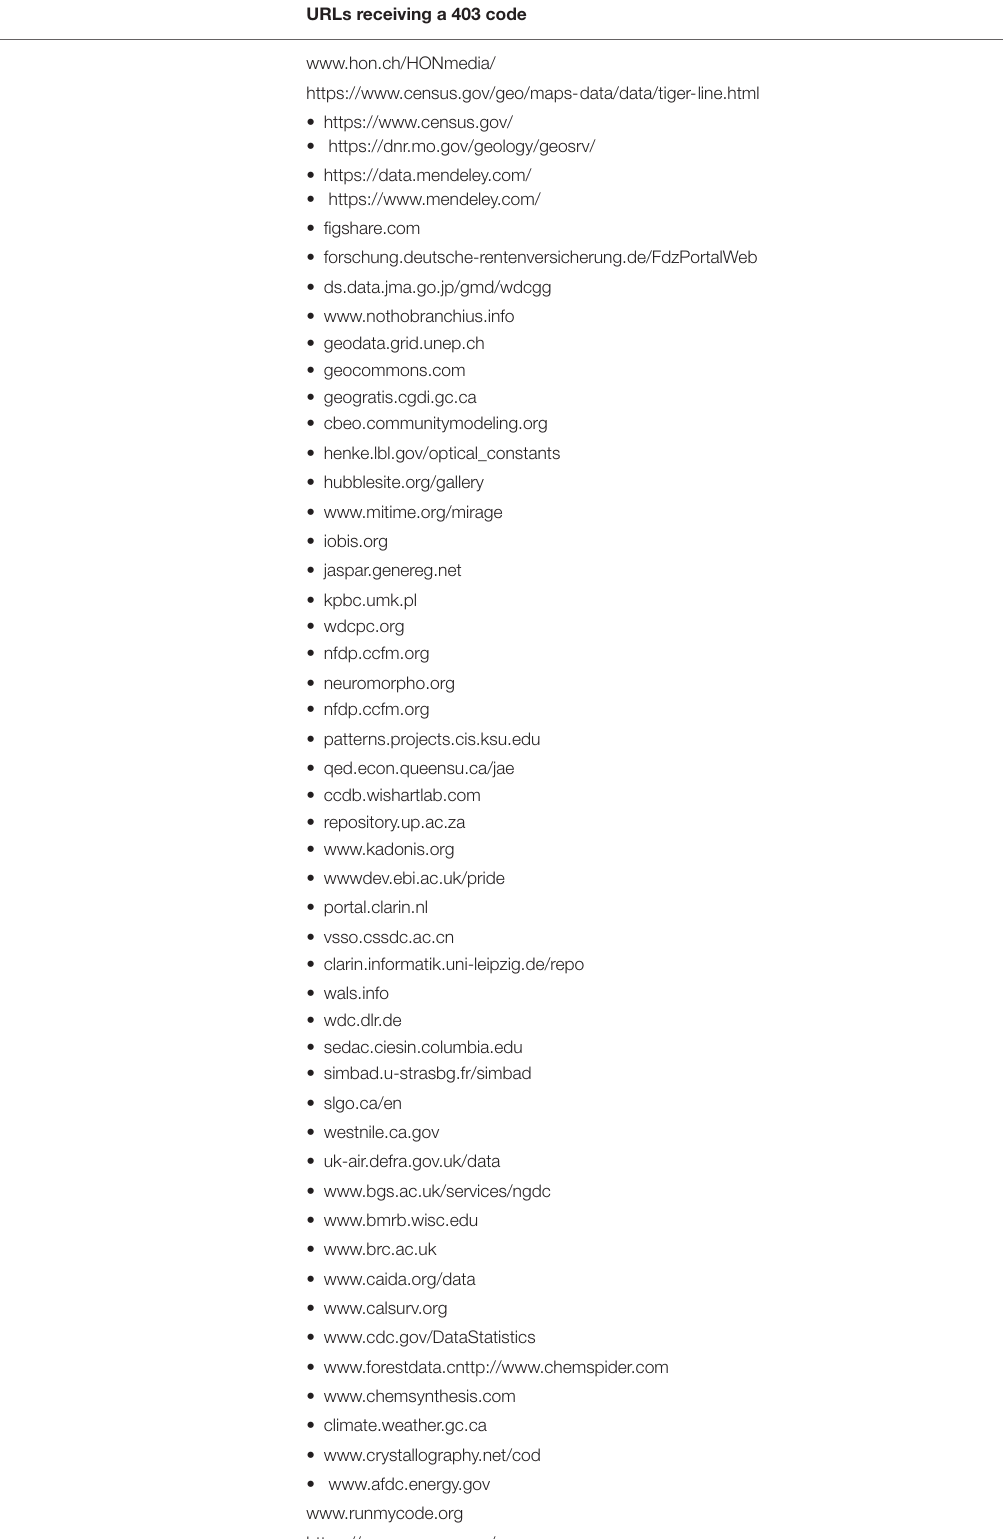
TABLE A1 | URLs that returned a 403 response code for a given country (returning 200 for us). Country